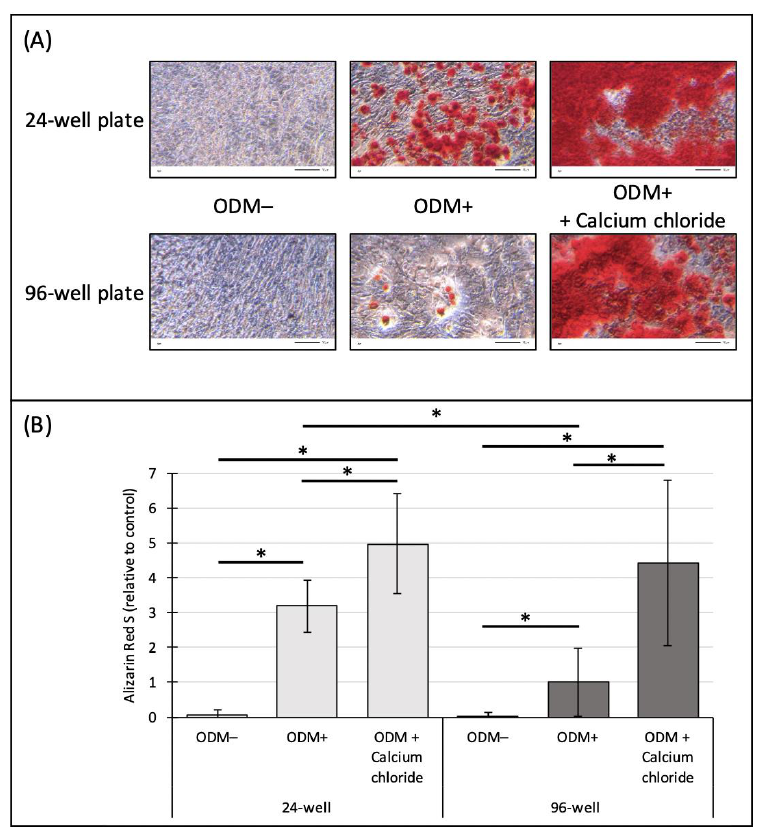
Figure 5. Effect of well size on alizarin red S staining of murine MC3T3-E1 osteoblasts. Murine osteoblasts were stimulated with osteoblast differentiation medium (ODM+) and in combination with calcium chloride (5 mM) in 24- or 96-well plates for three weeks before alizarin red S staining was performed. ODM− served as a negative control. ( A ) Representative pictures of alizarin red S-stained MC3T3-E1 osteoblasts assessed with transmitted light microscopy at 20× magnification are shown. Scale bar is 50 µm. ( B ) Concentrations of alizarin red S were calculated photometrically and are represented relative to the ODM+ reference of the 96-well plate. Means ± standard deviation from three independent experiments using sextuplicates are shown. * Indicates a significant difference ( p < 0.001).